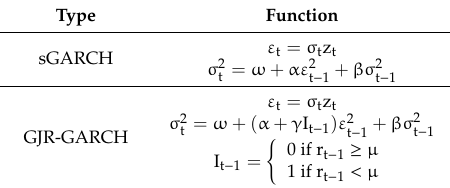
Table 1. Generalized autoregressive conditional heteroscedasticity (GARCH) model